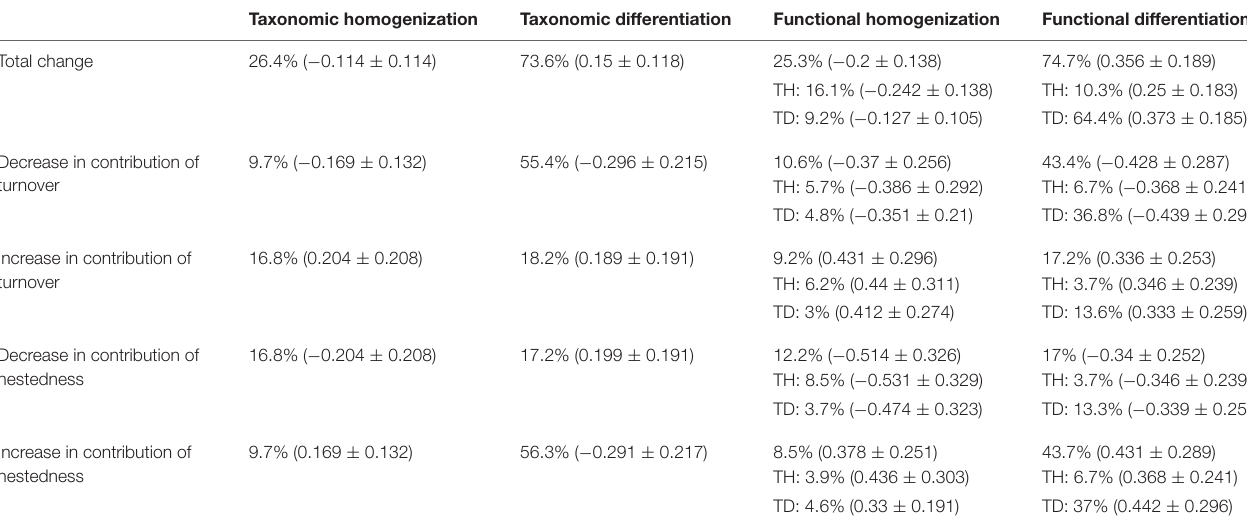
TABLE 2 | Summary of frequency and intensity of changes in taxonomic dissimilarity, functional dissimilarity and contribution of functional turnover to functional dissimilarity across the study